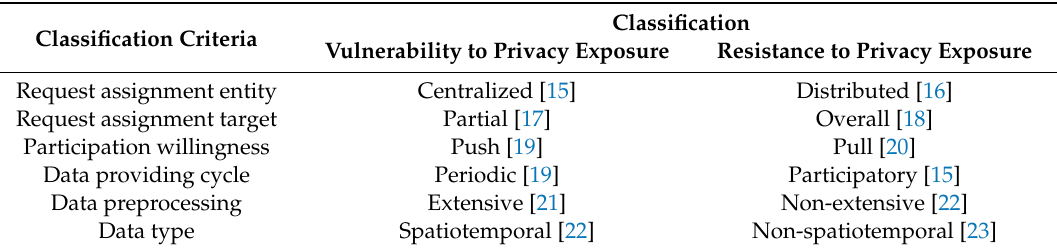
Table 1. Classification of crowdsensing